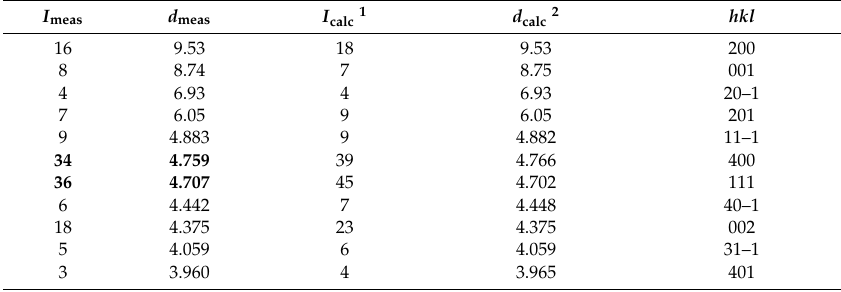
Table 2. Powder X-ray di ff raction data ( d in Å) for shuiskite-(Cr). The strongest reflections are given in